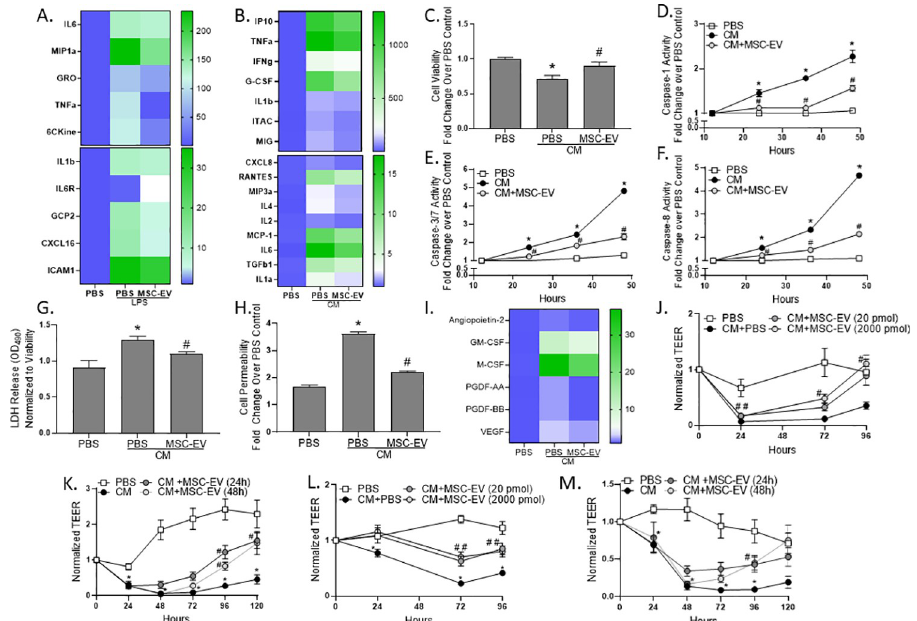
Fig 2. MSC-EVs decrease epithelial cell inflammation and improve cell health. Cytokine secretion was measured in (A) THP1 cell culture media after LPS administration and (B) calu-3 cell culture media after tri-cytokine addition (CM). Calu-3 cell viability was evaluated after a 24-hour CM exposure (C). Caspase-1 (D), caspase-3/7 (E), and caspase-8 (F) activities were evaluated in calu-3 cell lysates over time. LDH release into calu-3 culture media (G), cell permeability (H), and growth factor secretion into the media (I). Transepithelial/endothelial electrical resistance (TEER) was evaluated on primary human alveolar type 2 (AT2) after 24-hour (J) or 72-hour CM exposure (K). AT2 in co-culture with microvascular endothelial cells (MVEC) after 24-hour (L) or 72-hour CM exposure (M). Error bars are SEM of the mean. � p � 0.05 vs PBS control; #p � 0.05 vs CM.